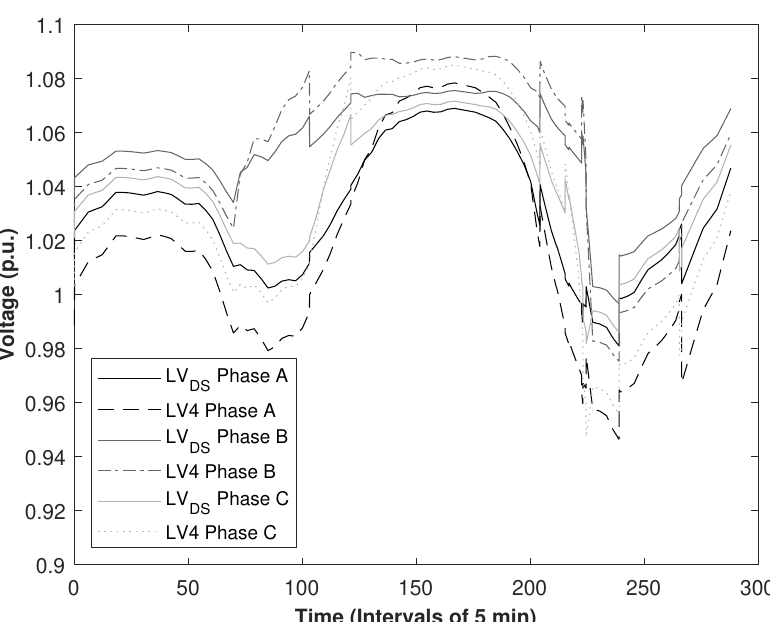
Figure 9. Voltage at LV DS and LV4 using the proposed volt/var control